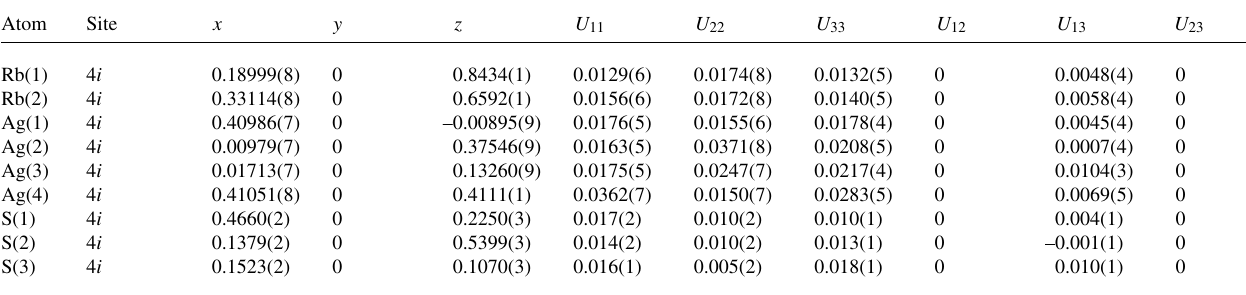
Table 2. Atomic coordinates and displacement parameters (in Å 2 )